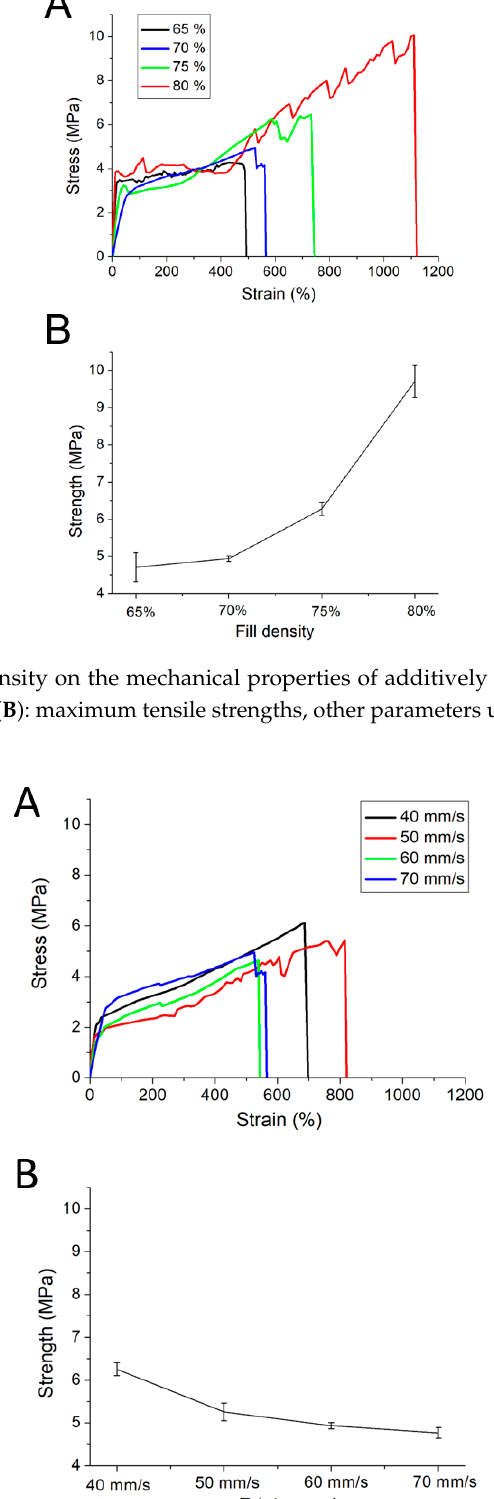
Figure 7. Effect of print speed on the mechanical properties of additively manufactured PCL parts (A: stress strain curves; B: maximum tensile strengths, other parameters used were those of Level 2 in Table 1).